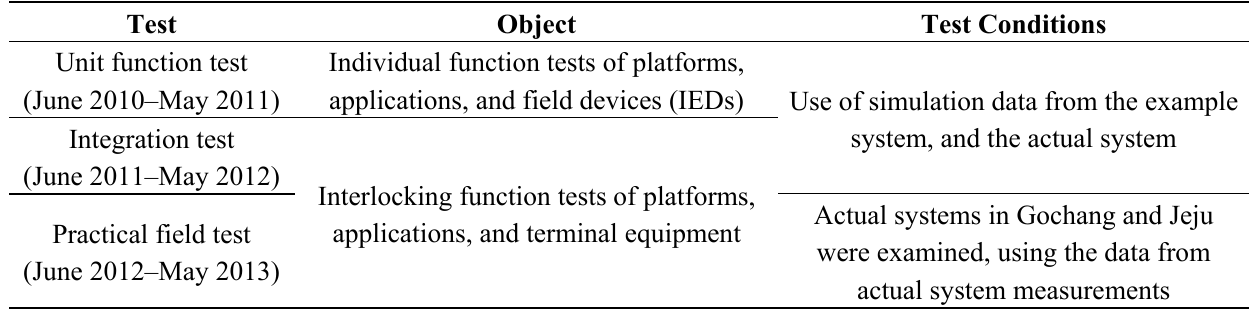
Table 4. KSDMS test.